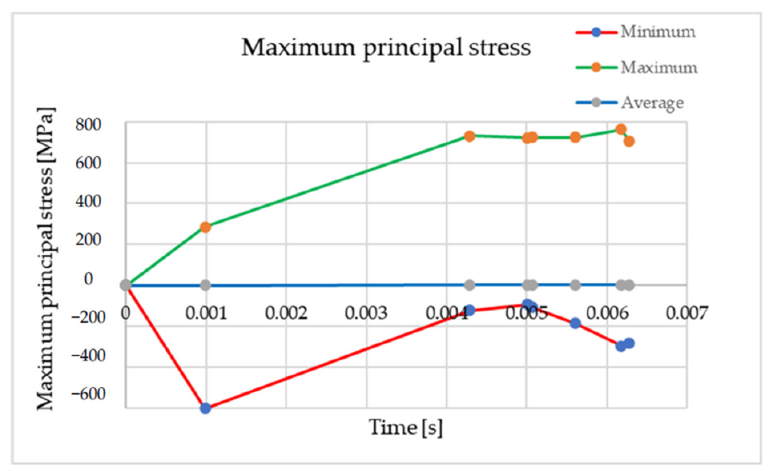
Figure 15. Diagram of Maximum Principal Stress. Table 8. Maximum principal stress.